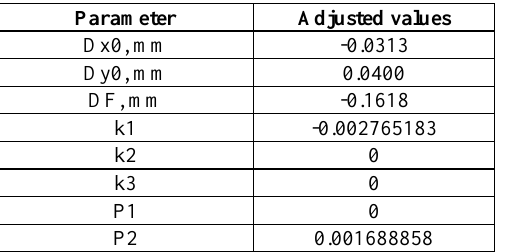
Table 3. Calibration of Lunokhod